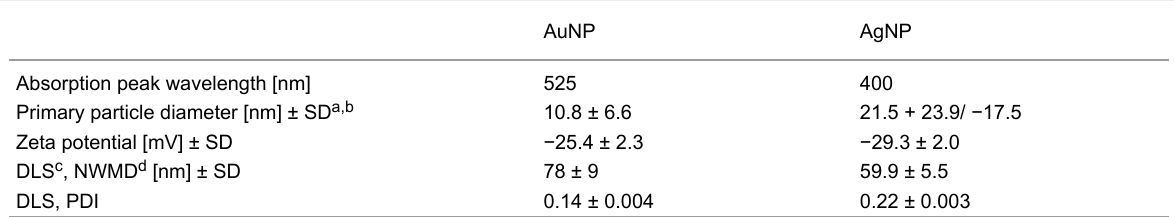
Table 1: Gold and silver nanoparticle characteristics after synthesis by laser ablation.